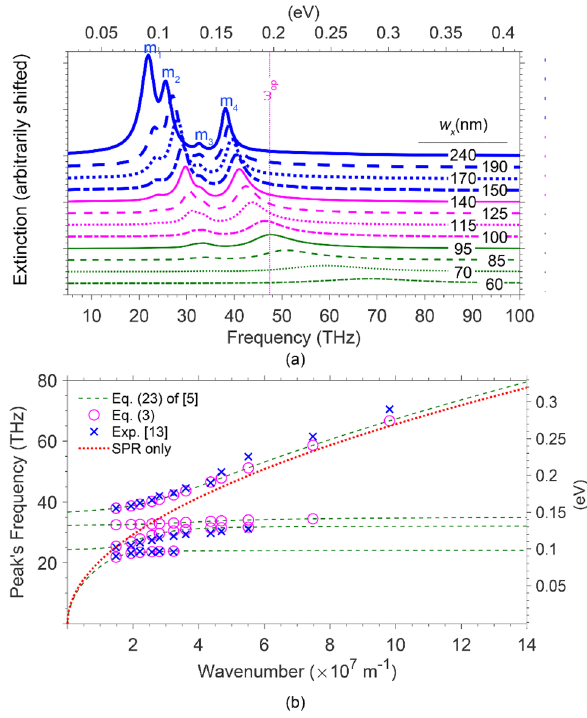
Figure 5. ( a ) Extinction spectra for graphene ribbons of different ribbons widths (60 ≤ w ≤ 240 nm) and μ C = 0.6 eV placed on SiO 2 . These spectra are vertically displaced for clarity. The vertical dashed line indicates the graphene optical phonon frequency. The labels m 1 − m 4 denote the peaks of the four coupled phonons-plasmons modes. ( b ) Peaks of the four coupled modes frequencies versus the plasmons’ wavevector, q , extracted from (a). The open circles represent the results obtained from (3), crosses depict the experimental results extracted from 13 , and the four dashed lines represent the modes dispersions calculated using (23) of 5 . The red dots depict the dispersion of the SPRs with no optical phonons